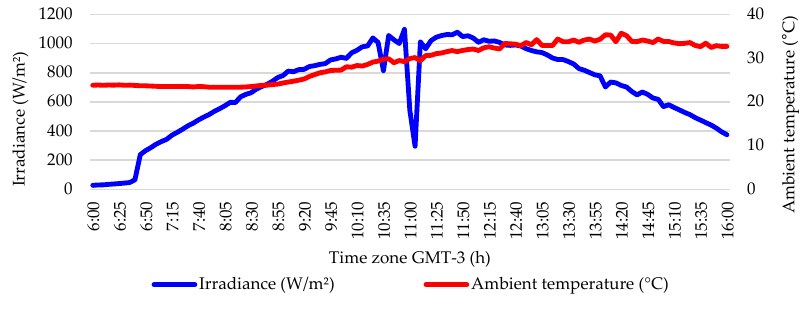
Figure 9. Shading condition.